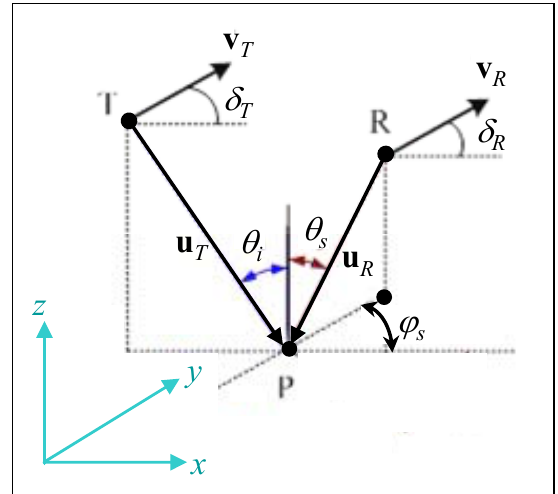
Figure 7. Geometry for evaluating the bistatic spatial resolution. T, R and P represent the positions of transmitter, receiver and target,